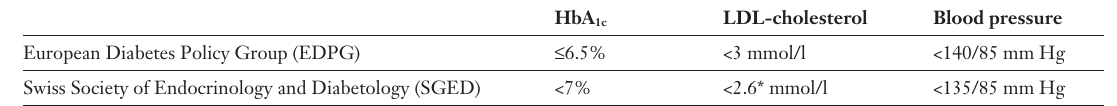
Table 1 Guidelines for treat- ment goals as recom- mended by different professional organi-